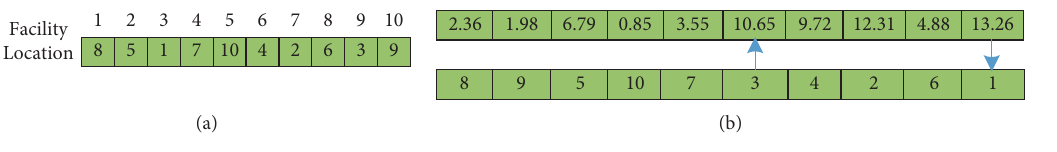
Figure 7: (a) Solution representation; (b) real value mapping. Table 6: Wilcoxon signed rank test results. Table 5: Results of 4 algorithms on the 10 datasets. Problem ILxBBO Data